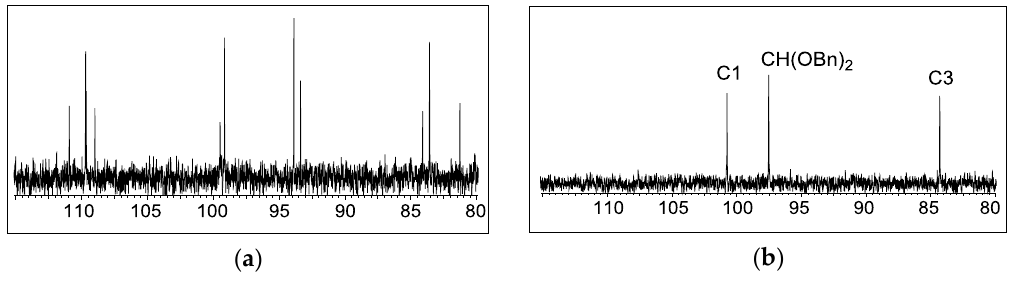
Figure 2. 13 C-NMR spectra of 4a in CDCl 3 ( a ) and DMSO- d 6 ; ( b ) in the range 80–115 ppm.